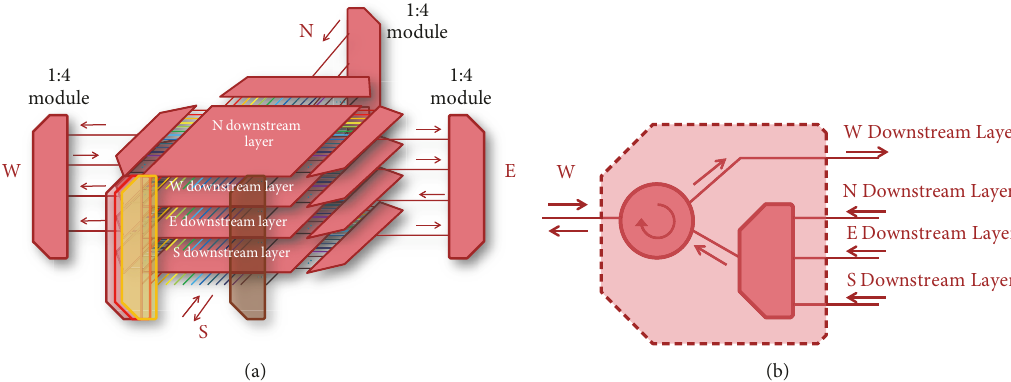
Figure 4: Multilayer reconfigurable optical add-drop multiplexer (ROADM) structure:(a) only downstream layers represented; (b) structure of a 1:4 downstream module.